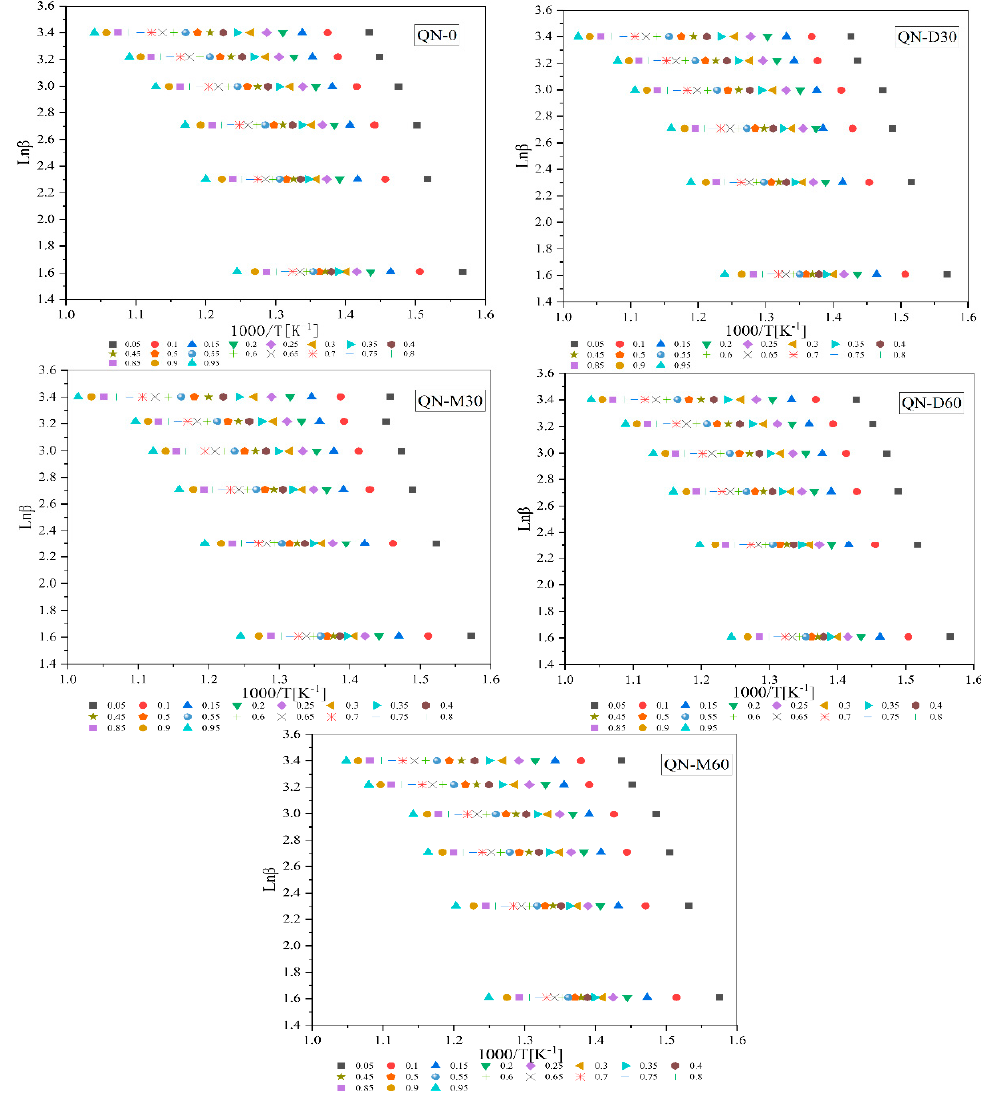
Figure 1. Thermal analysis fitting results of raw coal and water-soaked coal at different conversion